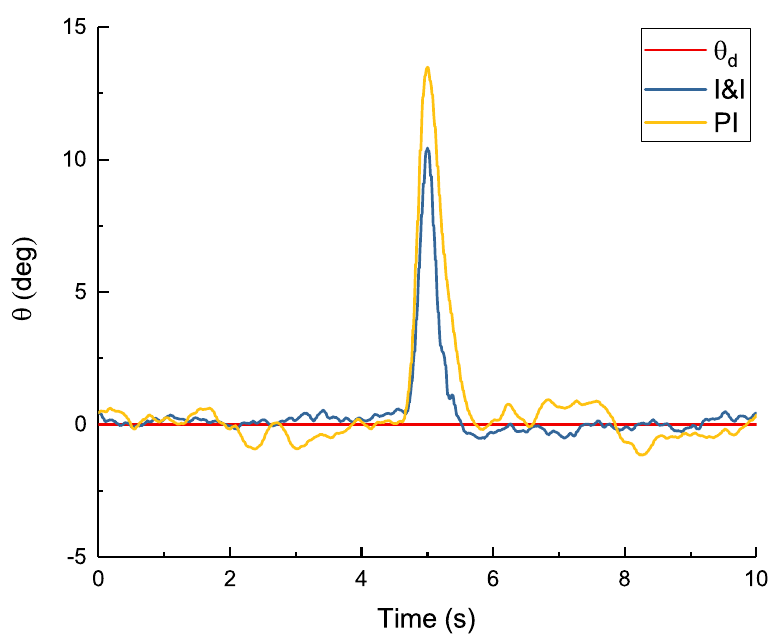
Figure 9. Pitch Control Comparison between I&I and PI